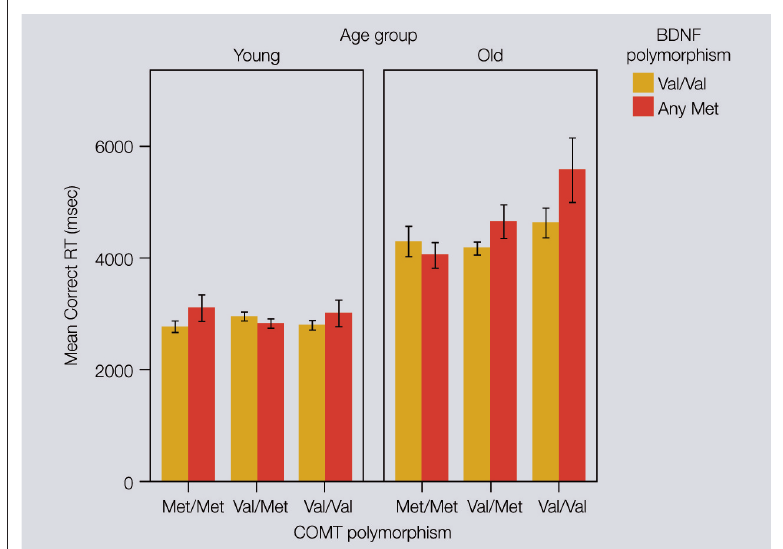
Figure 3 | Results from Nagel et al. (2008). Mean reaction time for correct WCST responses as a function of age, COMT genotype, and BDNF genotype. The age × COMT interaction accounted for 4.1%, and the age × COMT × BDNF interaction for 3.1% of the